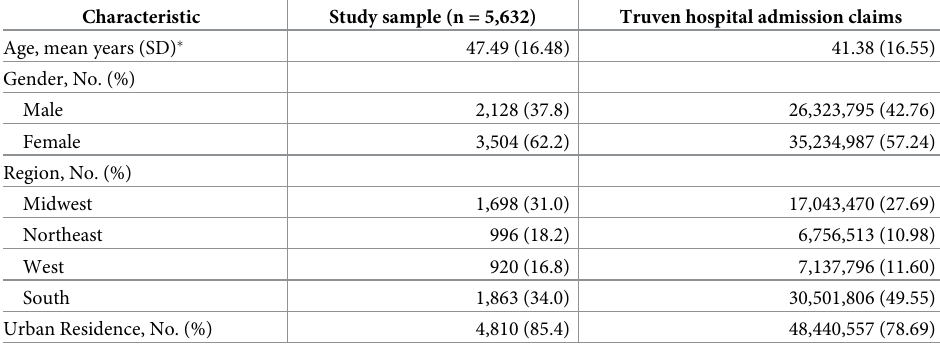
Table 1. Study sample baseline characteristics at index admission for Clostridium difficile compared with all Tru- ven hospital admission claims in 2011.